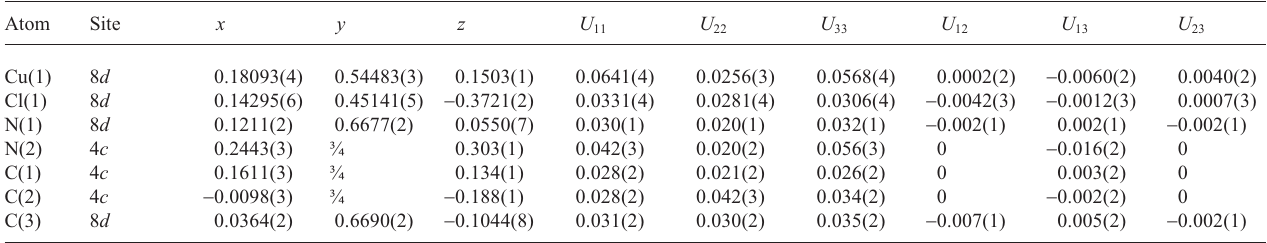
Table 3. Atomic coordinates and displacement parameters (in Å 2 )